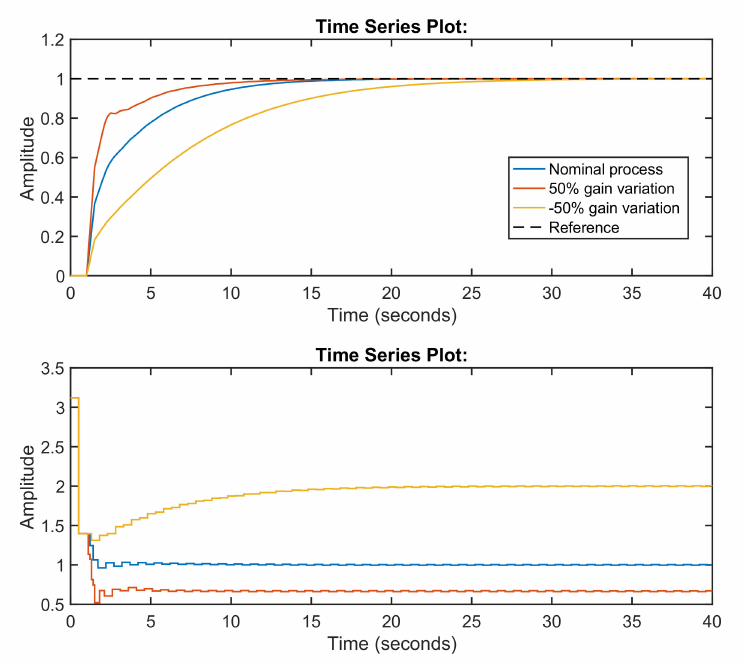
Figure 8. Robustness validation of the event-based FO-IMC controller (output signal in the upper plot, input signal in the lower